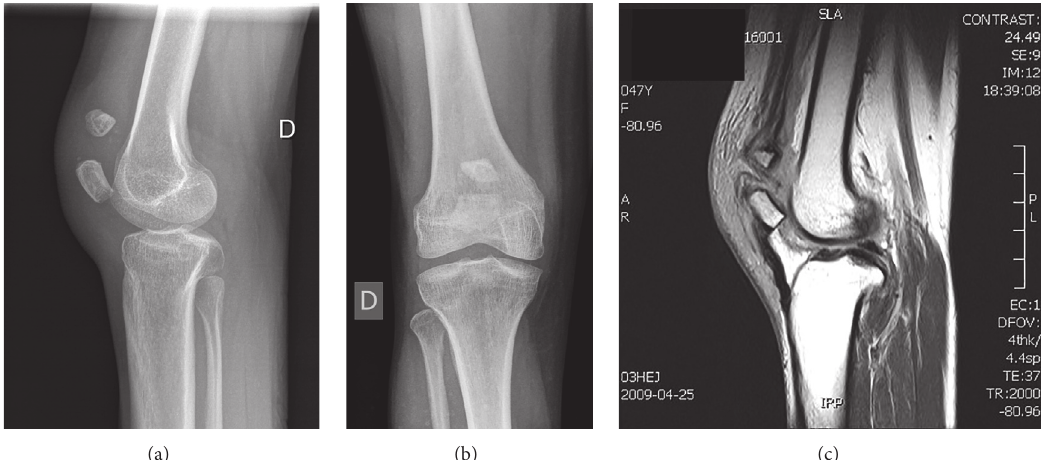
Figure 1: Lateral (a) and anteroposterior (b) knee views demonstrating a gap between the two parts of a duplicate patella. (c) Soft tissue is identified between the two parts of the patella (MRI T1 sagittal view).